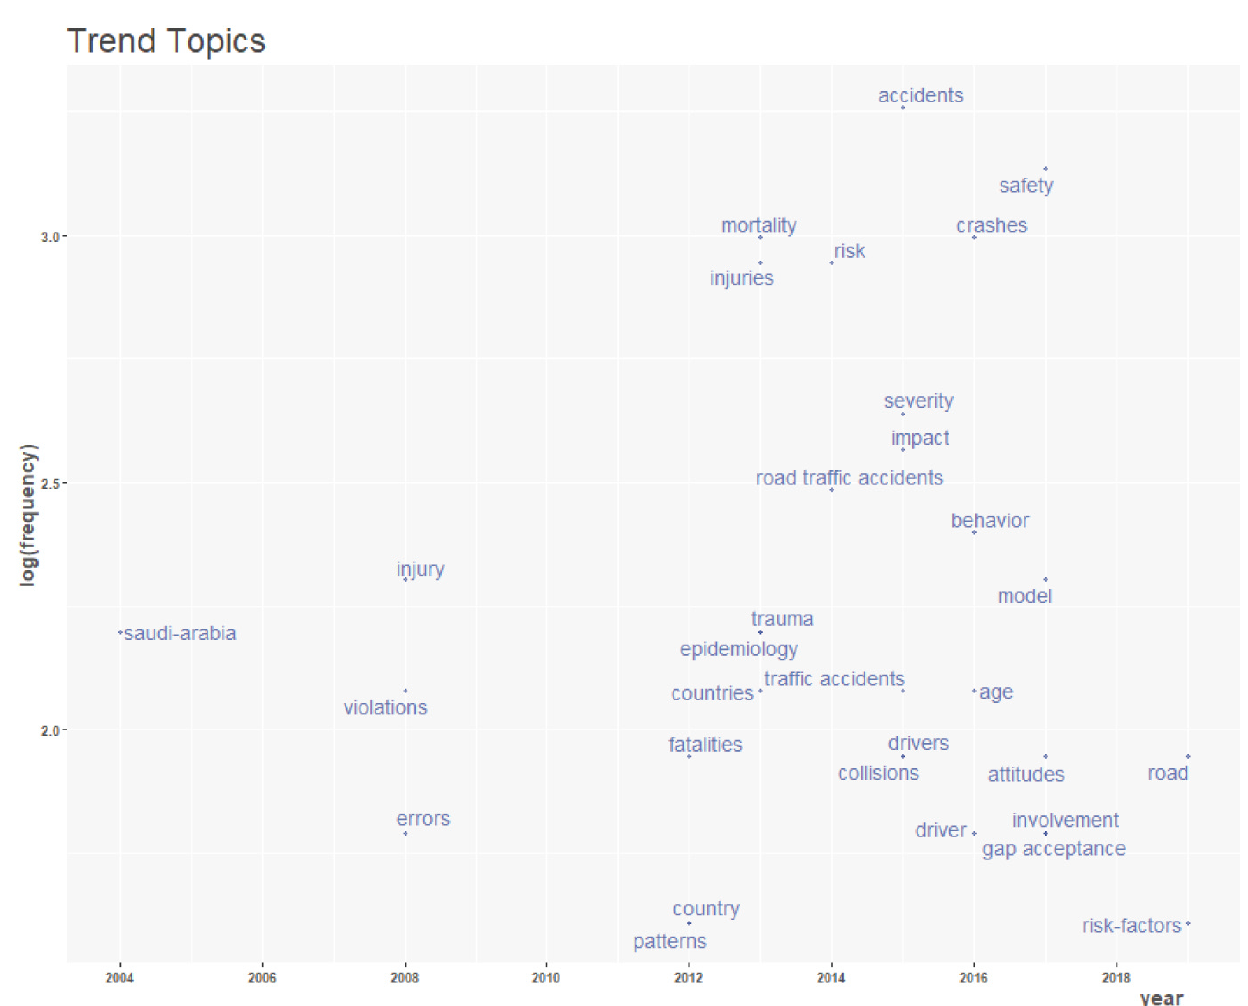
Figure 8. Topical trends in road traffic injuries research in the Gulf Cooperation Council region (1992–2018) based on the five most common keywords per year appearing five or more times. (generated using Biblioshiny Software R